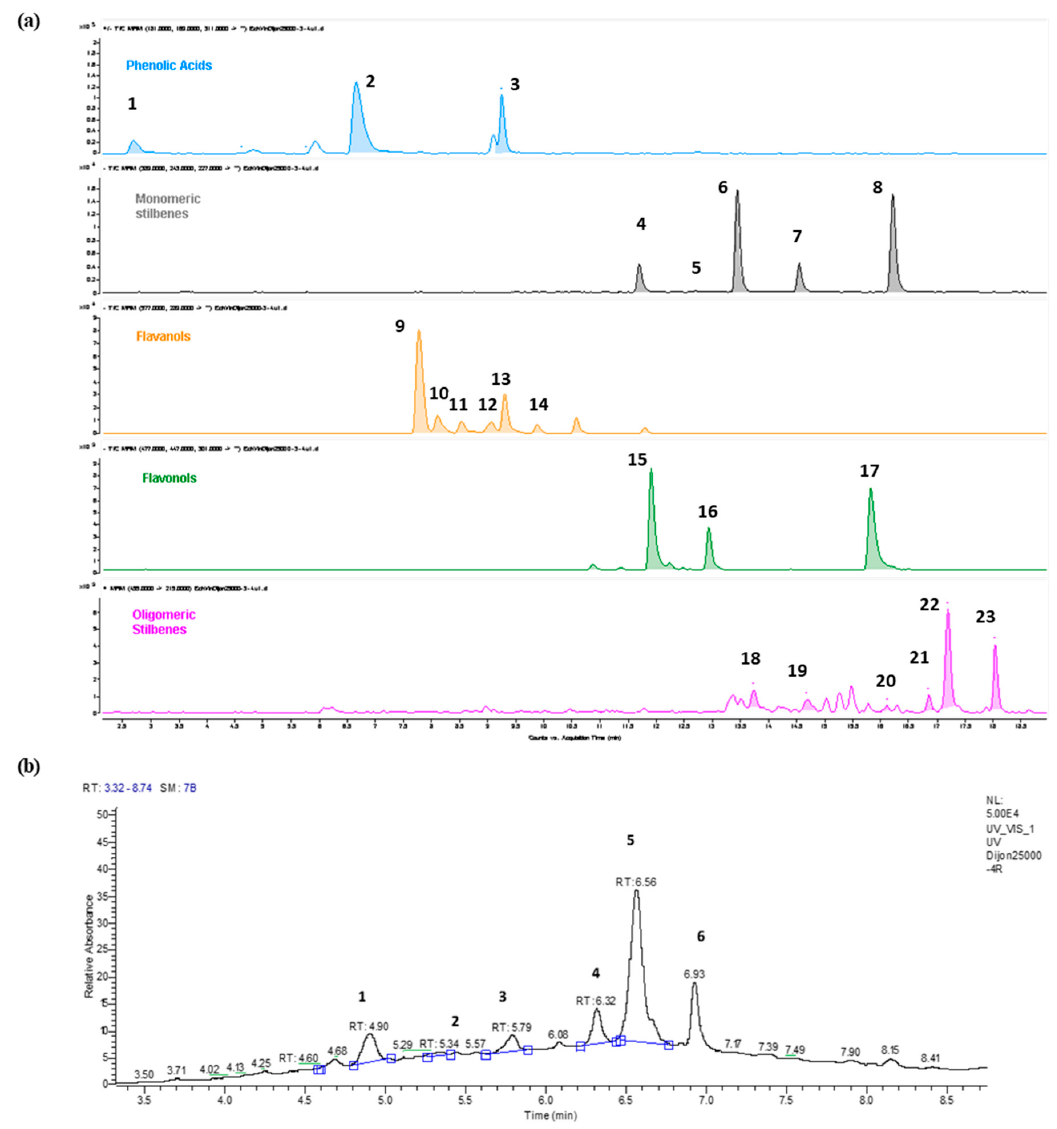
Figure 2. ( a ) Extracted ion chromatogram of the MRM transitions belonging to the main phenolic non-anthocyanin compounds detected in the wine extract. 1 = Gallic Acid; 2 = Caftaric Acid; 3 = Caffeic Acid; 4 = t- Piceid; 5 = t- Piceatannol; 6 = c- Piceid; 7 = t -Resveratrol; 8 = c-Resveratrol; 9 = Procyanidin B1; 10 = Procyanidin B3; 11 = Catechin; 12 = Procyanidin B4; 13 = Procyanidin B2; 14 = Epicatechin; 15 = Quercetin-3-glucuronide; 16 = Quercetin-3-rhamnoside; 17 = Quercetin; 18 = Pallidol; 19 = Parthenocisin A; 20 = Isohopeaphenol; 21 = c -E-viniferin; 22 = t -E-viniferin, 23 = t -w-viniferin. ( b ) UV520 Chromatogram of the main anthocyanins detected in the red wine extract. 1 = Delphinidin 3-glucoside; 2 = Cyanidin 3-glucoside; 3 = Petunidin 3-glucoside; 4 = Peonidin 3-glucoside; 5 = Malvidin 3-glucoside; 6 = Malvidin acylated derivative.